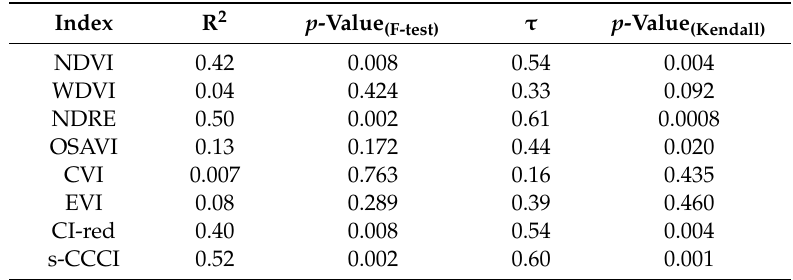
Table 6. Results of correlation analysis of the multispectral vegetation indices, contained in Table 2, on 24 June and their relationships to the harvested crop yield on 20 July. The coe ffi cient of determination, p -value of the statistical F-test, non-parametric Kendall’s rank correlation tau, and its significance are expressed as R 2 , p -value (F-test) , τ , p -value (Kendall) ,